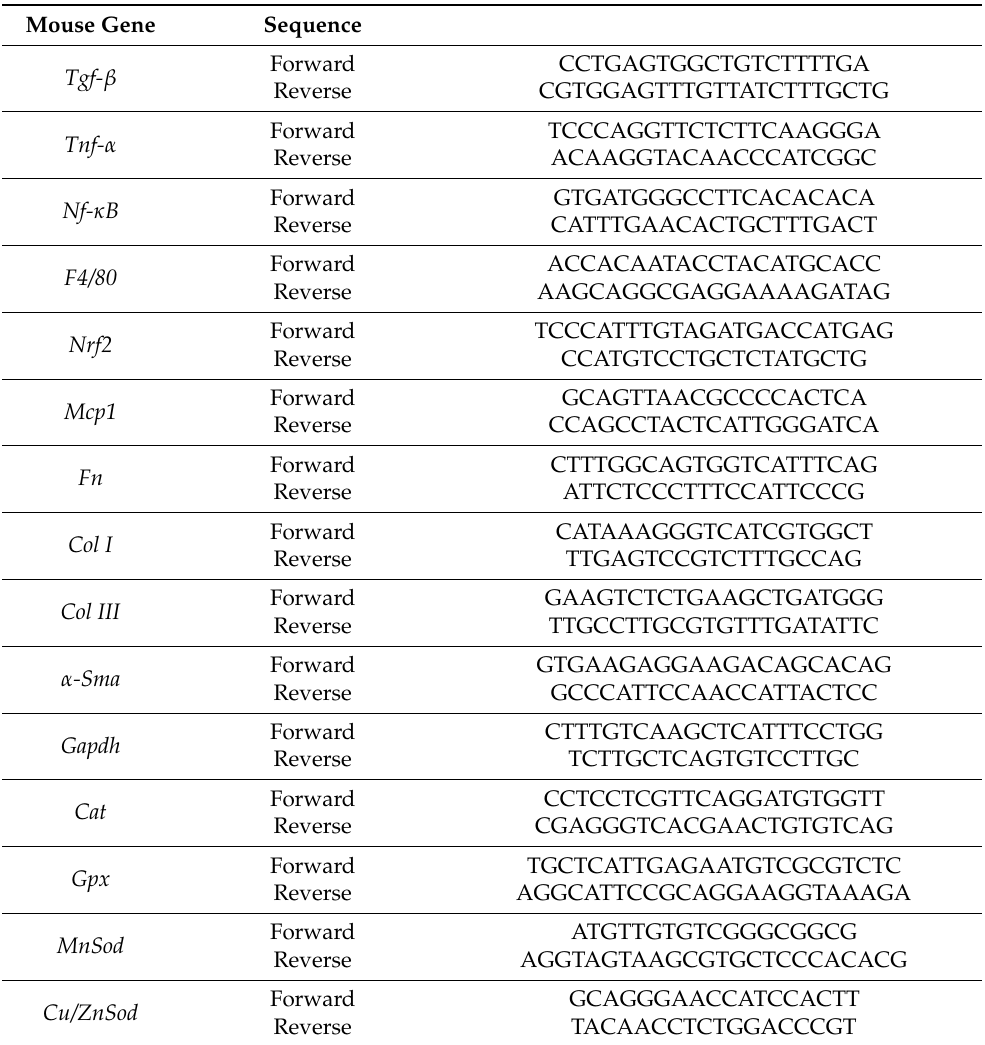
Table 1. Primers used for reverse transcribed-quantitative polymerase chain reaction (RT-qPCR). Transforming growth Figure 4. nuclear factor erythroid 2-related factor 2 ( Nrf2 ); monocyte